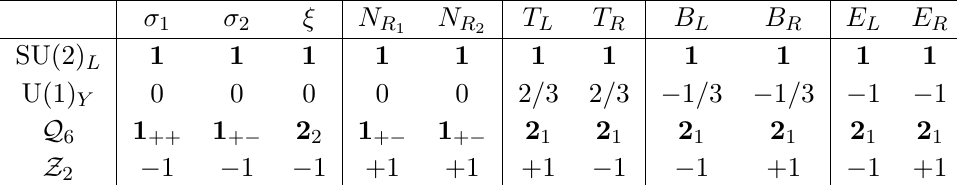
Q ≡ ( Q Q L L 1 , Q L 2 ) 6 doublets as, D T and ‘ T . ≡ ( ‘ R D R 1 , ‘ R 2 )